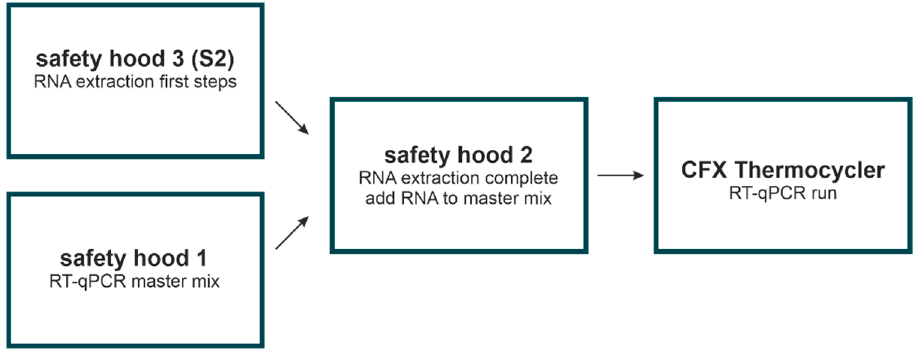
Figure 2. Room separation. Shown are the different steps of our in-house protocol performed in